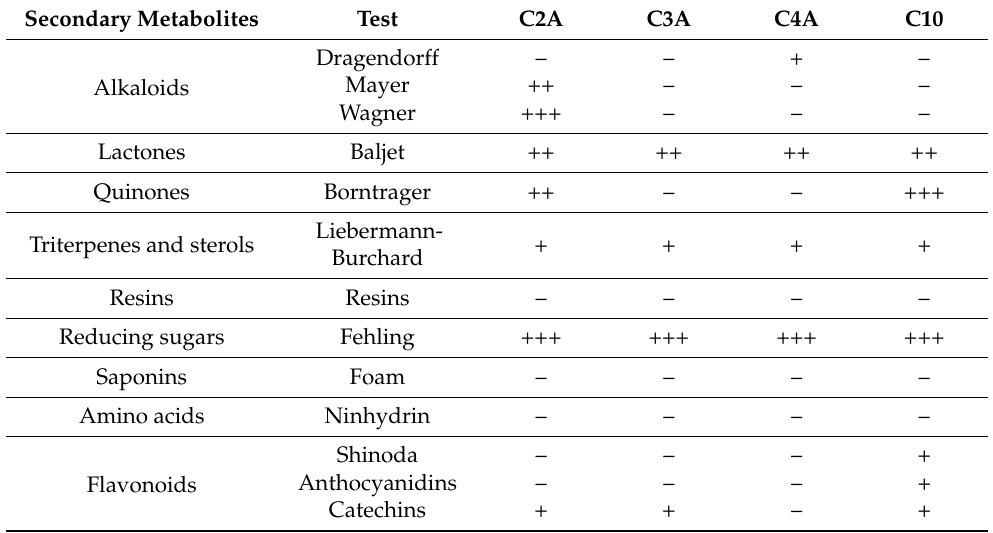
Table 1. Chemical screening of Trichoderma spp. ethyl acetate